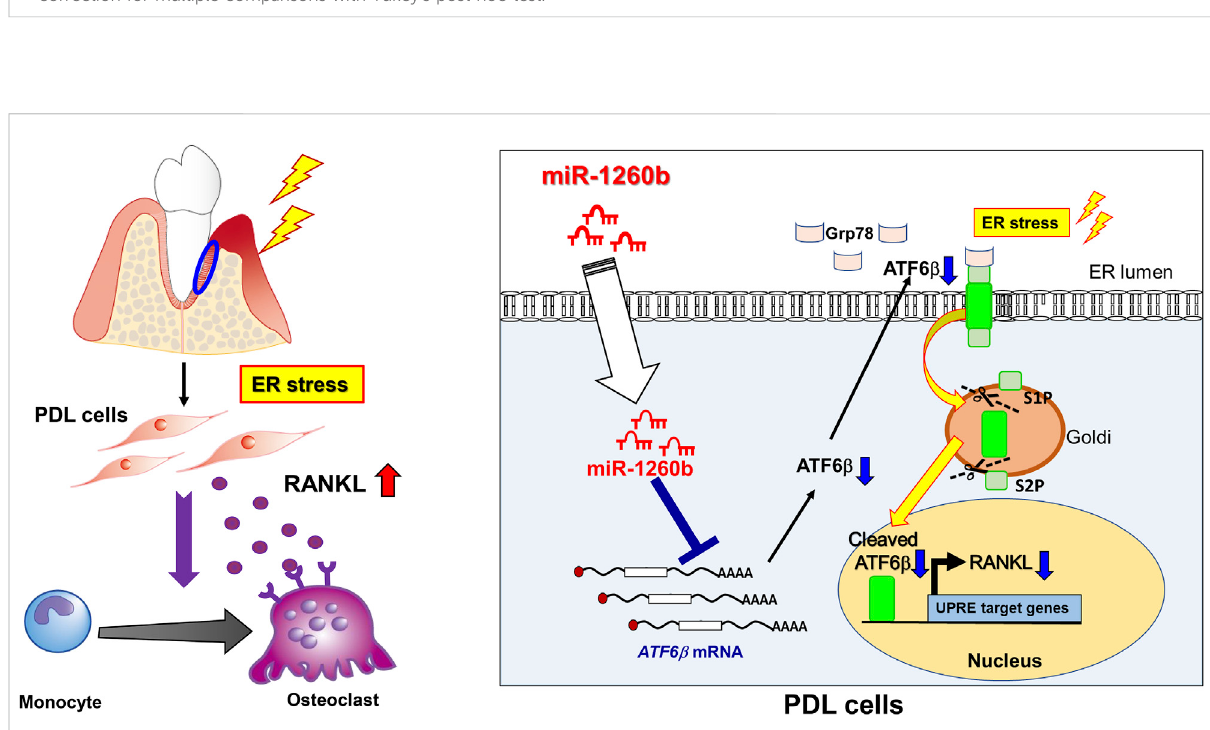
Therapeutic effects of miR-1260b on osteoclastogenesis in periodontal disease by targeting ATF6 β -mediated ER stress. (left) Under pathological condition, ER stress is upregulated in periodontal tissue. PDL cells produce RANKL to stimulate osteoclast differentiation, which cause alveolar bone resorption. (right) In PDL cells, ATF6 β binds to Grp78 and localize at ER lumen. During ER stress, ATF6 β dissociate from Grp78 and cleaved by Site-1 protease (S1P) and Site-2 protease (S2P). The active from of cleaved-ATF6 β translocate to nucleus and enhance